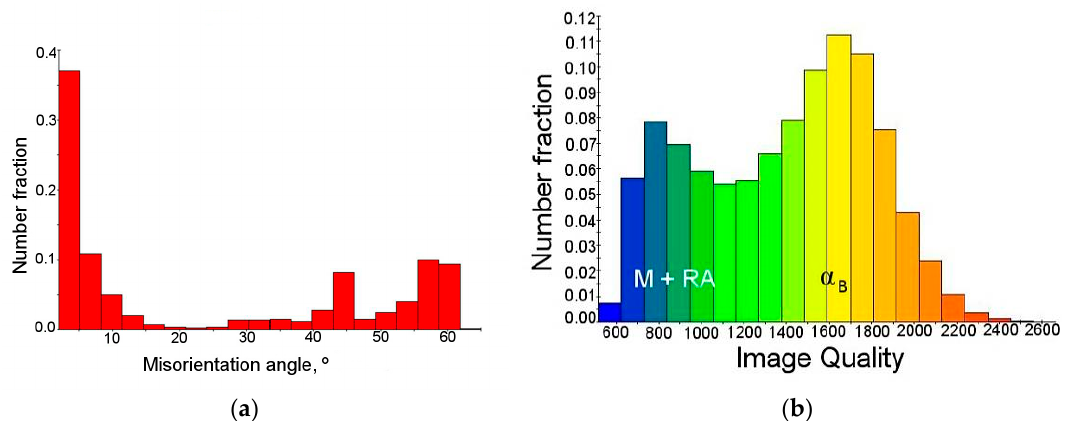
Figure 11. Distribution of misorientation angle ( a ) and IQ parameter ( b ) of the sample elongated to 10%. The morphological details of strain ‐ induced martensite obtained as a result of the applied tensile load were revealed by using TEM. Figure 12a showed the fine ‐ plate martensite formed within the